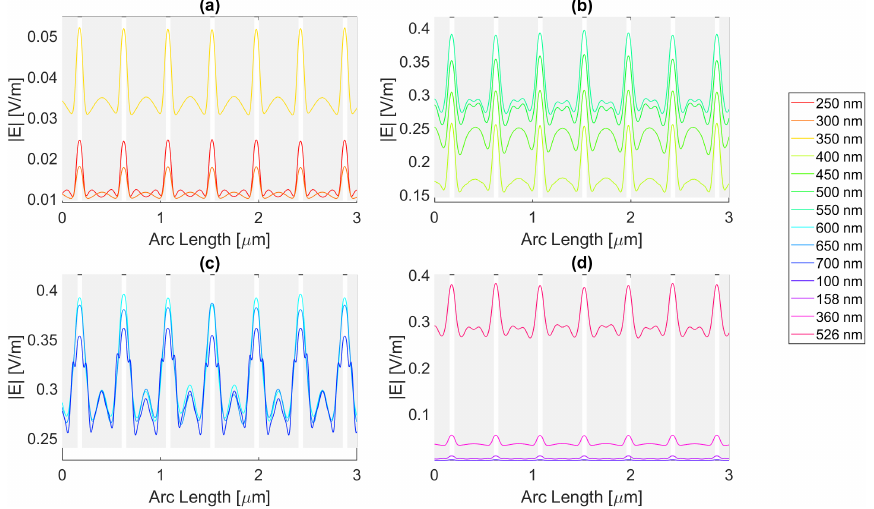
Figure 7. Electric field for copper 20-nm-thick rectangular nanostructure—Probe 1.